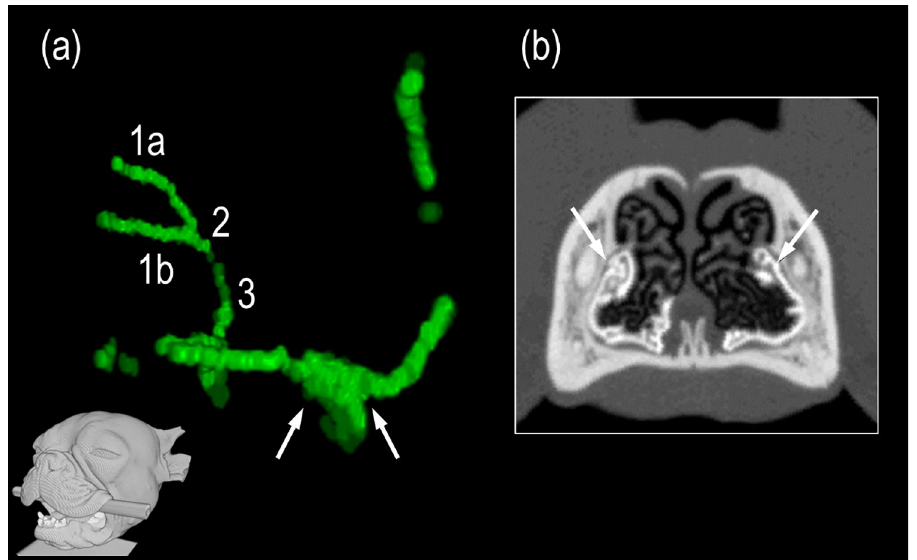
Fig 8. Accessory opening of the nasolacrimal system (NLS). (a) Three-dimensional illustration of the entire, contrast agent-filled bilateral NLS. The viewing perspective is represented by the head at the bottom of the picture. The white arrows point to the accessory opening of the left nasolacrimal duct. The contrast agent (shown in green) emerges from the opening. (1a) right upper lacrimal canaliculi, (1b) right lower lacrimal canaliculi, (2) right lacrimal sac, (3) right nasolacrimal duct. (b) Transverse CT-image of the nose. The white arrows point to the accessory opening, from which contrast agent emerges into the nasal cavity. From there, the contrast medium flows along the lateral nasal mucosa and collects on the floor of the nasal